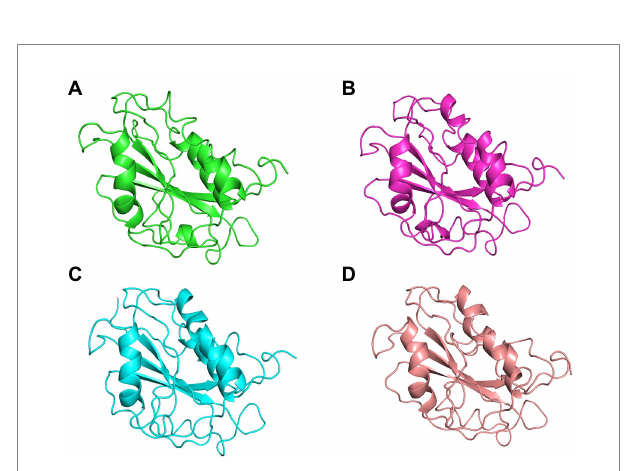
FIGURE 8 The centroid structures of each cluster attained from the clustering of ASP_Indie-C1 trajectory (A) Cluster 1 (C1) 1,000th ps, (B) Cluster 2 (C2) 81,100th ps, (C) Cluster 3 (C3) 29,800th ps, and (D) Cluster 4 (C4) 50,500th ps.